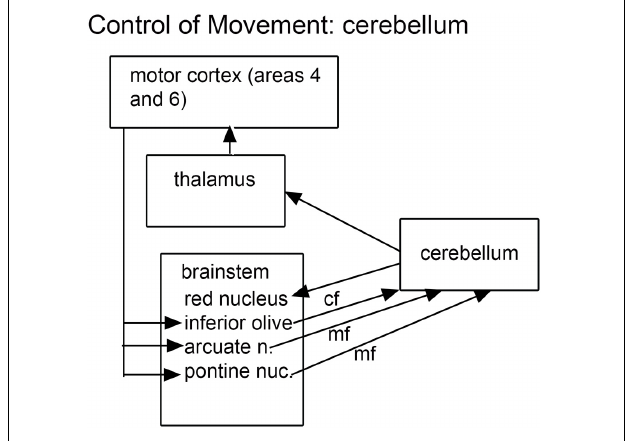
FIGURE 1 | The brainstem inputs and outputs of the cerebellum. cf, climbing fibers; mf, mossy